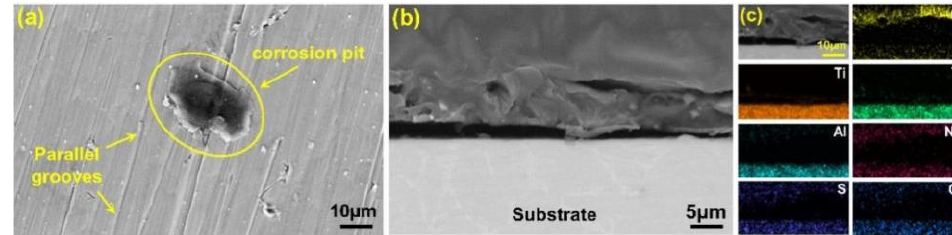
6 of 13 Figure 5. ( a ) XRD patterns of all tested samples; ( b ) color change of deionized water after washing of sample H4; ( c ) Ti2p spectrum of sample H1; and ( d ) O1s spectrum of sample H3. Figure 6 displays the surface and cross-sectional SEM images and EDS spectra of